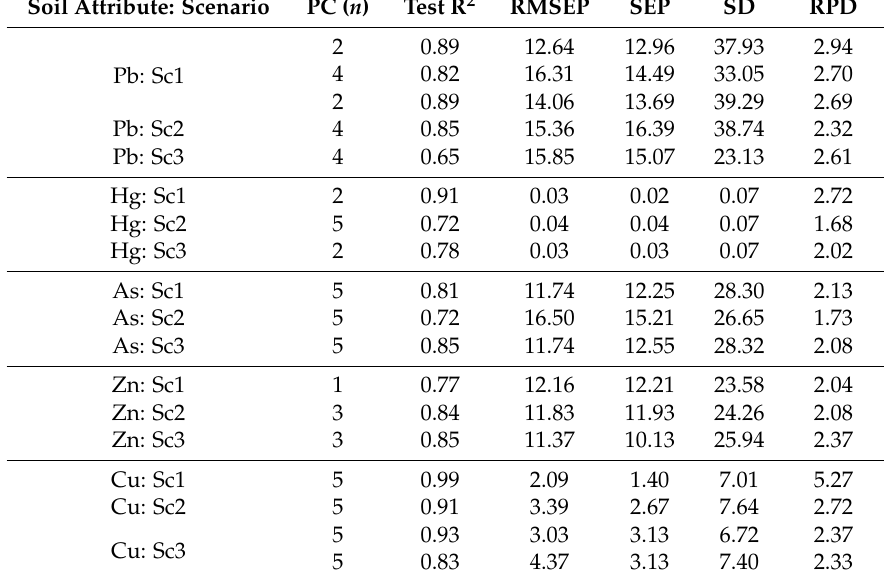
Table 6. PLSR Models for heavy metals (Pb, Hg, As, Zn, Cu): the best model statistics using